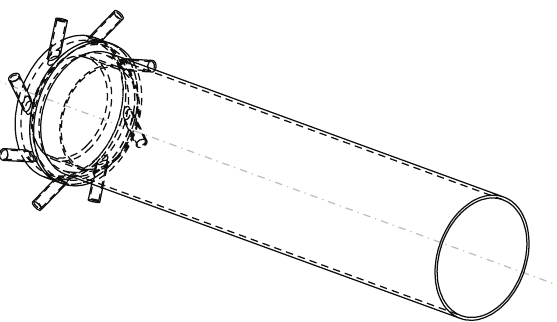
Figure 7: Scheme of the reactor with swirling ejecting jet.